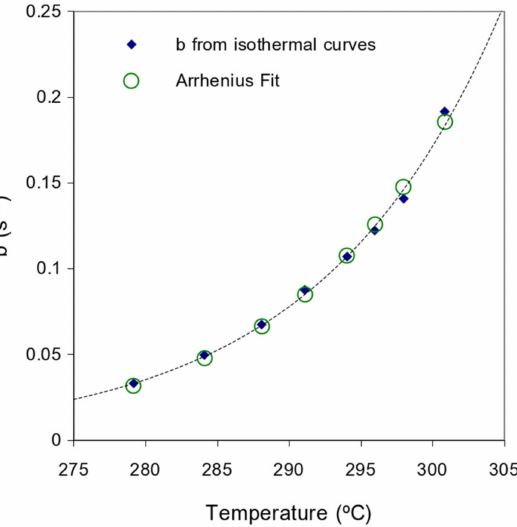
Figure 4. Plot of the rate parameter values obtained at different temperatures along with the fitting obtained through the Arrhenius equation.